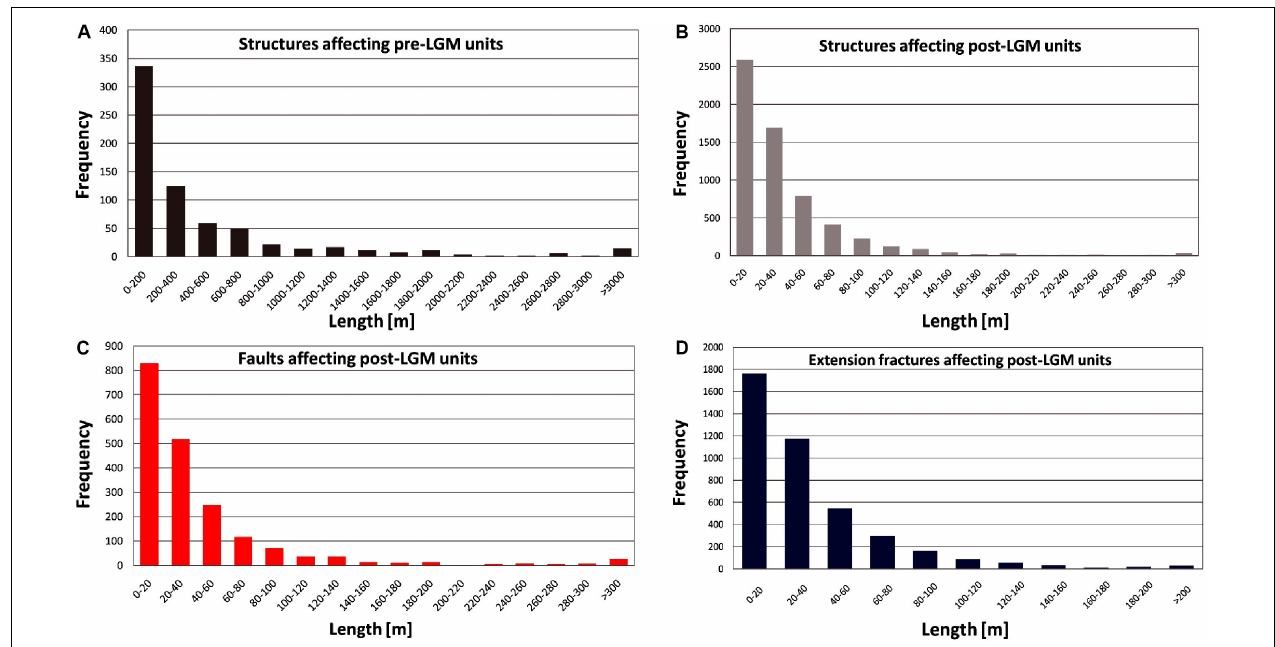
FIGURE 5 | (A) Length distribution of pre-LGM structures. (B) Length distribution of post-LGM structures. (C) Length distribution of post-LGM faults. (D) Length distribution of post-LGM extension